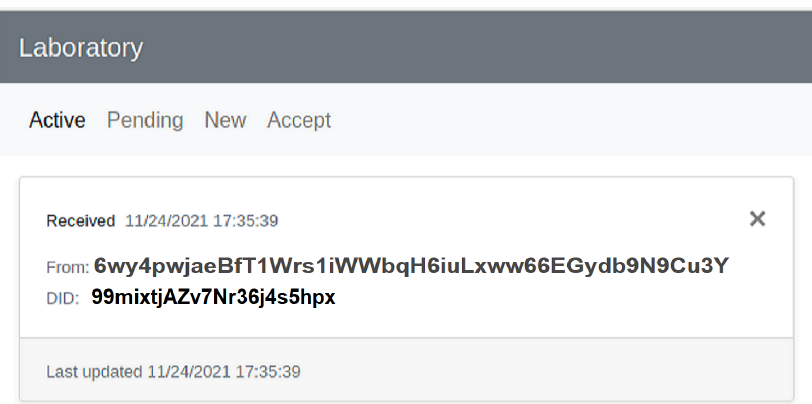
Figure 6. The laboratory creates a certificate attesting that DID belongs to the owner of the public